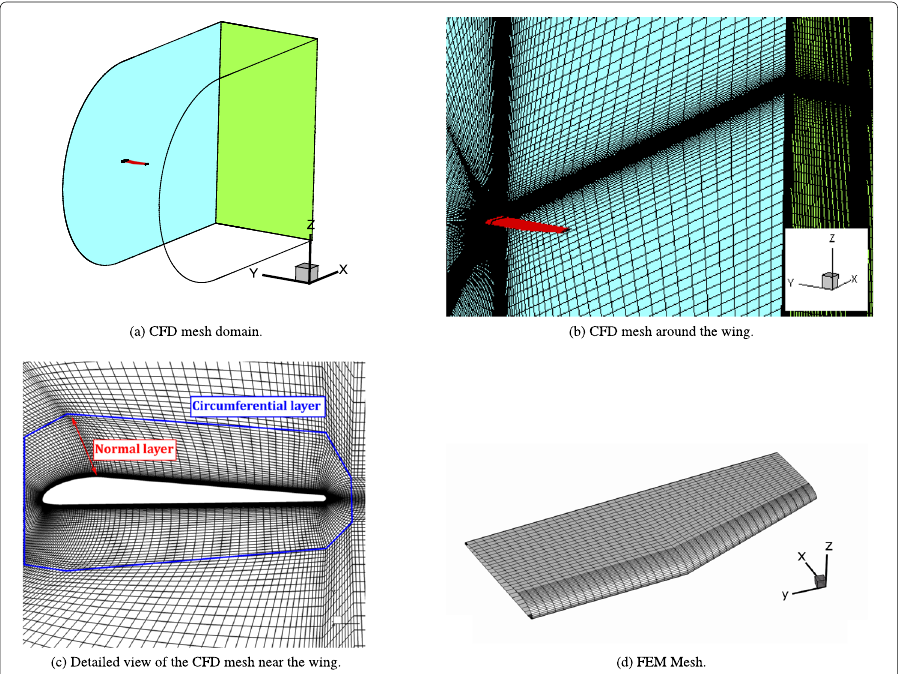
Fig. 5 CFD and FEM Meshes. a CFD mesh domain. b CFD mesh around the wing. c Detailed view of the CFD mesh near the wing. d FEM Mesh